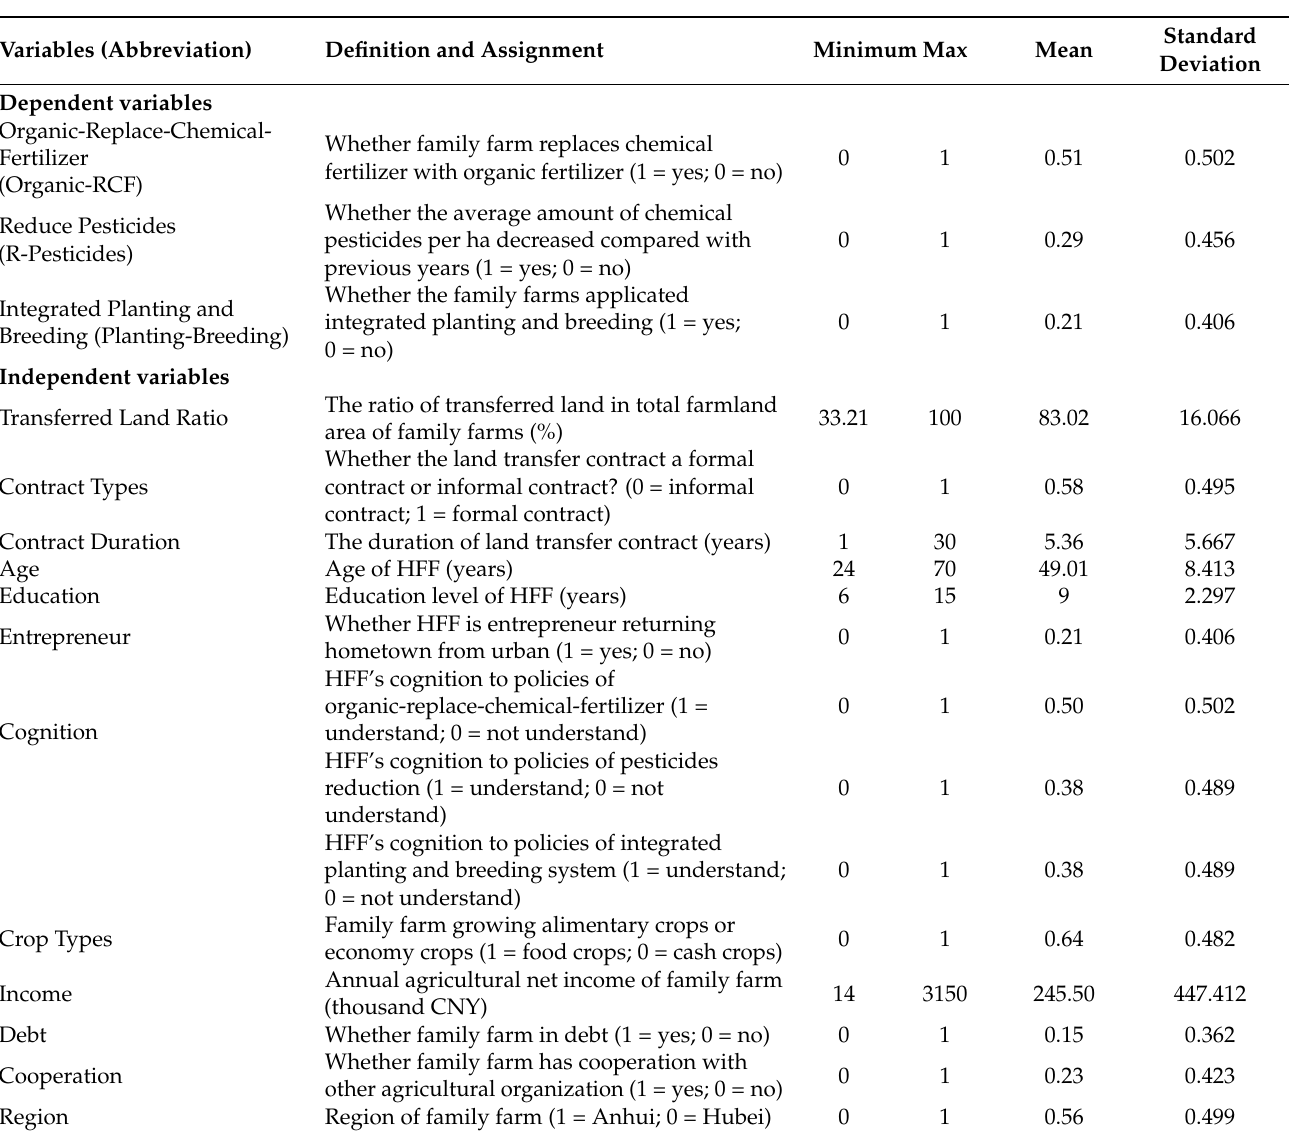
Table 2. Definition and assignment of